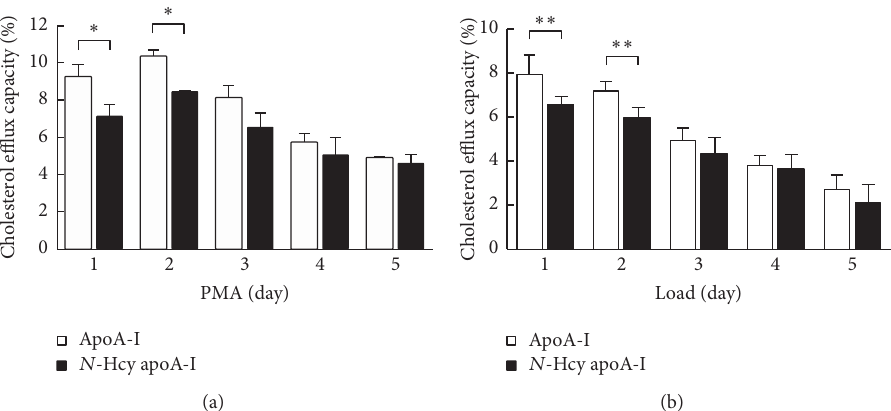
Figure 7: The effect of differentiation and foam cell formation on cholesterol efflux capacity of apoA-I and N -Hcy apoA-I. (a) After THP-1 cells were differentiated with PMA for different periods (1 to 5 days) and were loaded with 3 H-cholesterol (1 𝜇 Ci/mL), acLDL (50 𝜇 g/mL), and T0901317 (1 𝜇 mol/L) for 1 day, cholesterol efflux capacity was assessed by using apoA-I (10 𝜇 g/mL) or N -Hcy apoA-I (10 𝜇 g/mL). The values were indicated by mean + SD ( 𝑛 = 3 , ∗ 𝑃 < 0.05). (b) After PMA treatment for 2 days and loading with 3 H-cholesterol (1 𝜇 Ci/mL), acLDL (50 𝜇 g/mL), and T0901317 (1 𝜇 mol/L) for different periods (1 to 5 days), cholesterol efflux capacity was determined by using apoA-I (10 𝜇 g/mL) or N -Hcy apoA-I (10 𝜇 g/mL). The values were indicated by mean + SD ( 𝑛 = 6, ∗∗ 𝑃 <